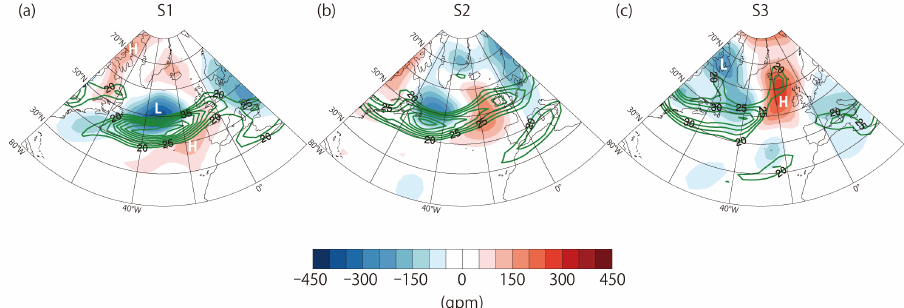
Figure 2. Daily mean geopotential height anomaly (red–blue contours) and zonal wind above 20 ms − 1 (green contours with an interval of 5 ms − 1 ) at 250 hPa for representative days in summer: ( a ) type S1 on 11 July, 2009; ( b ) type S2 on 1 August, 2016; and ( c ) type S3 on 26 July, 2011. “H” and “L” represent high and low geopotential height anomalies.